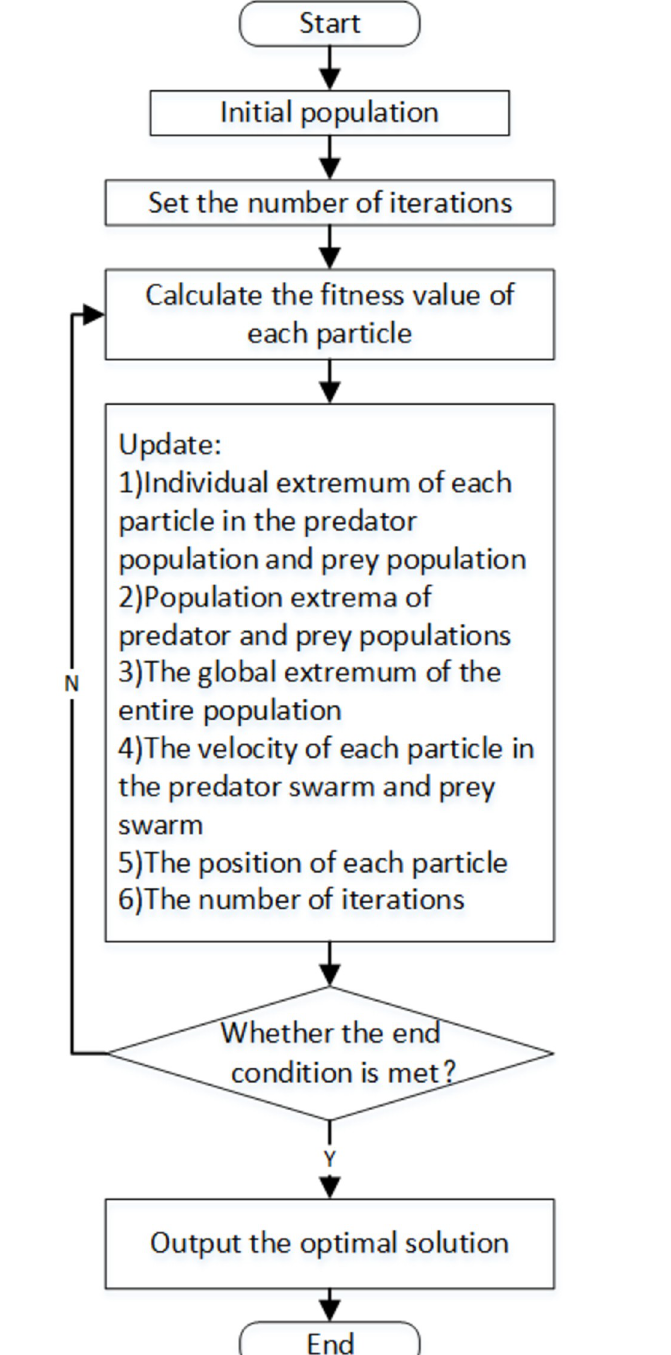
Fig 3. Flow chart of predator-prey particle swarm optimization.